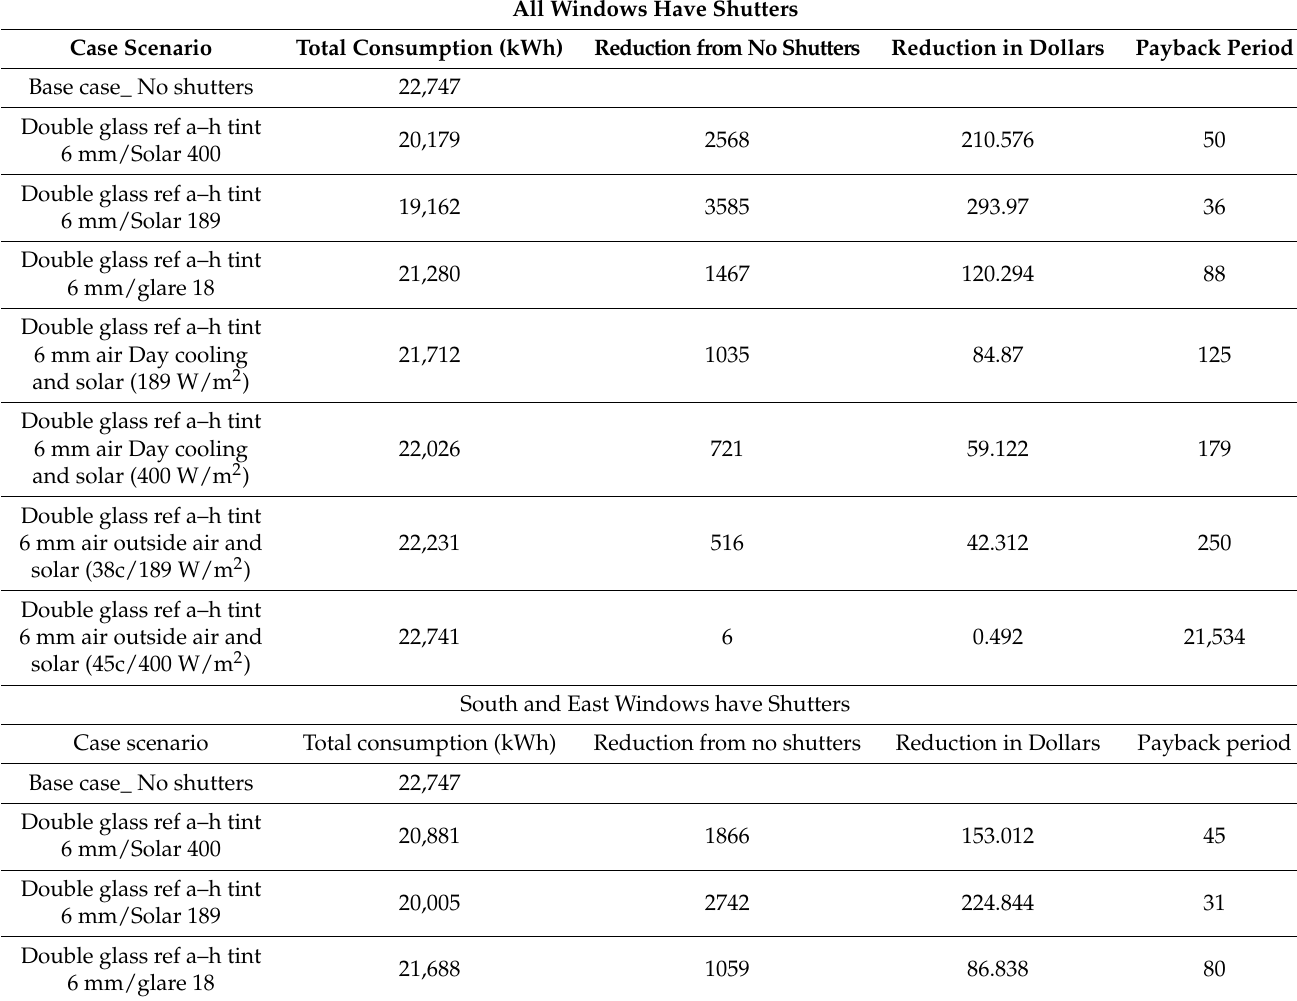
Table A1. Cost analysis of windows